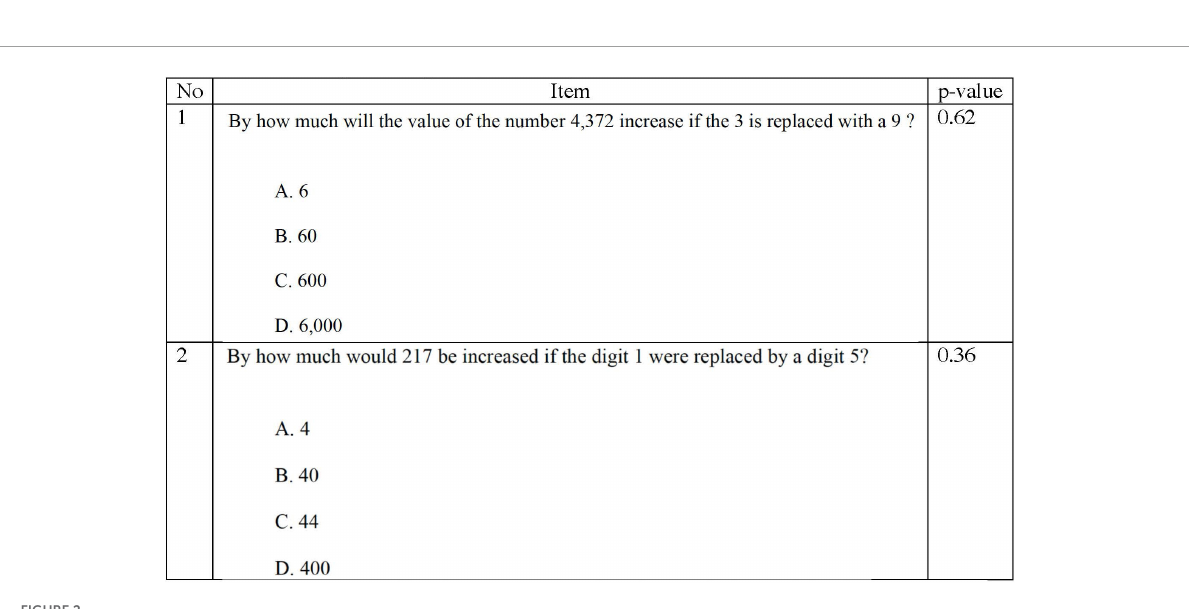
FIGURE2 NAEP items with different difficulty assessing place value. Source: U.S. Department of Education, Institute of Education Sciences, National Center for Education Statistics, National Assessment of Educational Progress (NAEP), 2007 and 1992 Mathematics